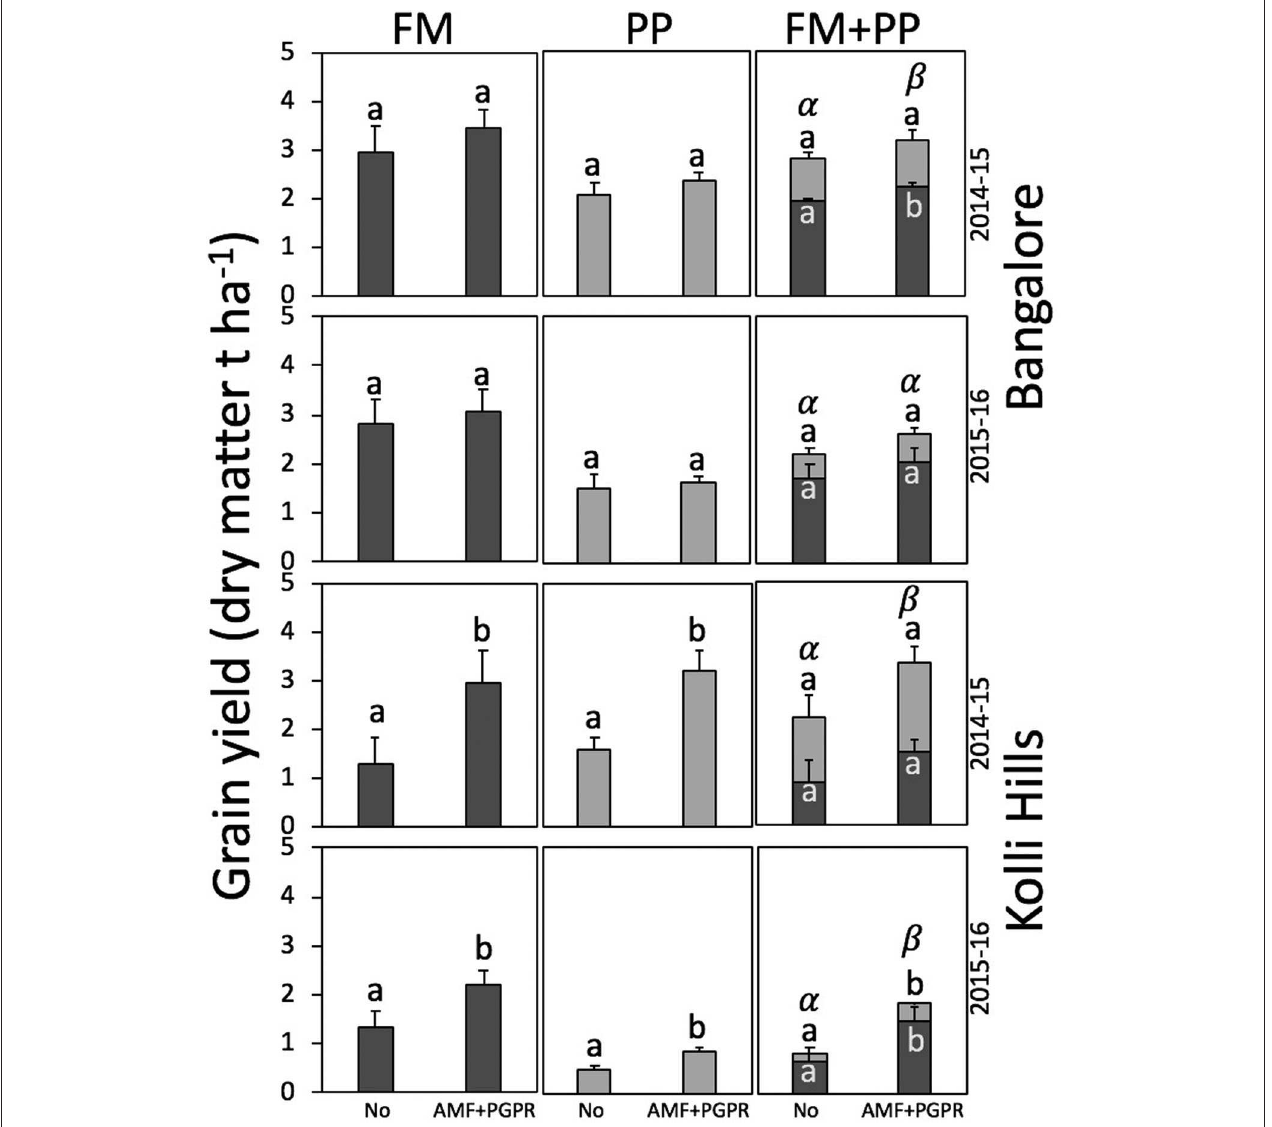
FIGURE 3 | Finger millet (dark shaded bars) and pigeon pea (light shaded bars) grain yield at 50% recommended dose of fertilizer (RDF) at Bangalore and Kolli Hills. Significant differences among means were calculated crop wise. Each error bar indicates + 1 standard deviation of the mean. Alpha ( α ) and beta ( β ) above the bars indicate letters of significance for combined grain yields of finger millet and pigeon pea. Bars not sharing the same letters are significantly different at p <